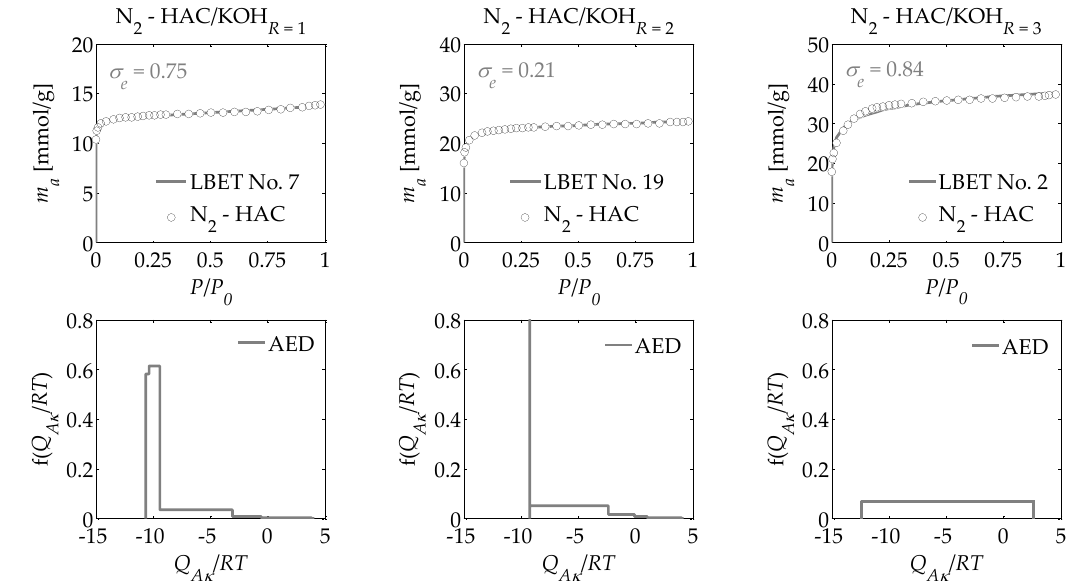
Figure 3. Same as Figure 1 but for the activated carbons HAC prepared from hornbeam wood.